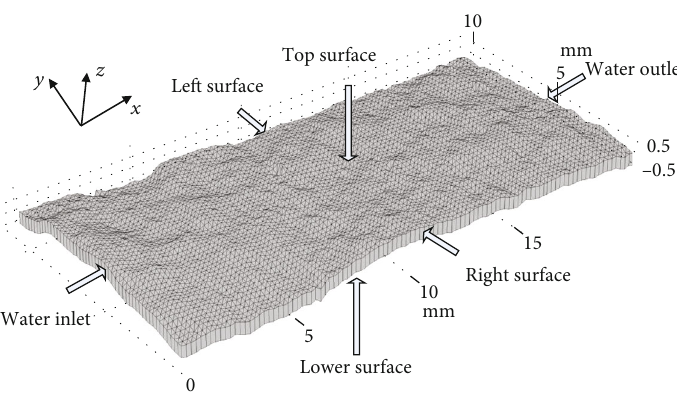
Figure 3: Fluid fl ow model of the rough-walled fracture surface (taking d = 0 : 5 mm as an